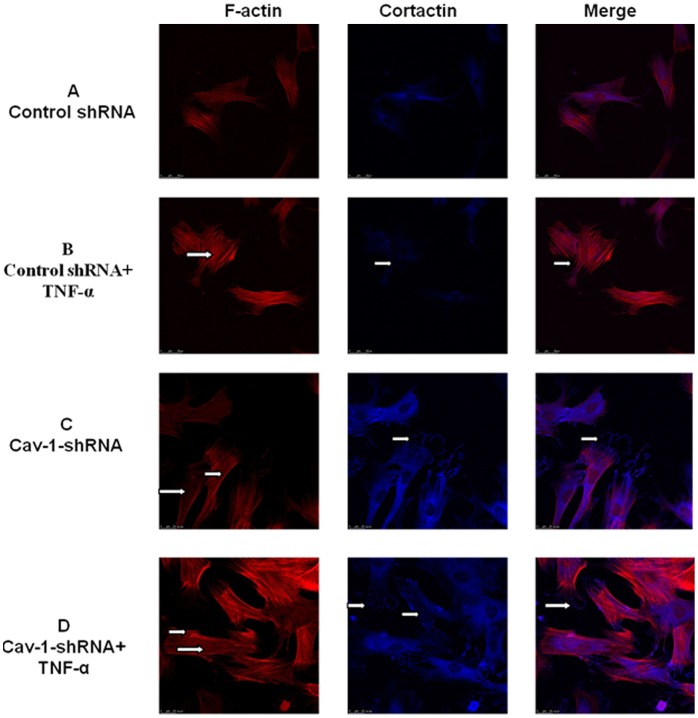
Effect of down-regulation of caveolin-1 on the rearrangement of F-actin and the distribution of cortactin.In control shRNA cells, few stress fibres were observed in the cytoplasm and cortactin was primarily located in the cytoplasm (A). Control shRNA cells exposure to TNF-α (B) induced stress fiber formation and the disappearance of cortactin from the cell periphery (shown by arrows); Down-regulation of caveolin-1 strengthened the peripheral actin band and induced an increase in the formation of lamellipodia and a change of cortactin localization to cell periphery forming a continuous linear staining pattern (shown by arrows) (C). Cav-1-shRNA cells exposure to TNF-α (D),remarkably, induced lamellipodia increasing and dramatically attenuated the disappearance of cortactin from the cell periphery, moreover, the levels of central actin stress fiber formation were not obvious (shown by arrows). All the images shown are representative of four independent experiments.